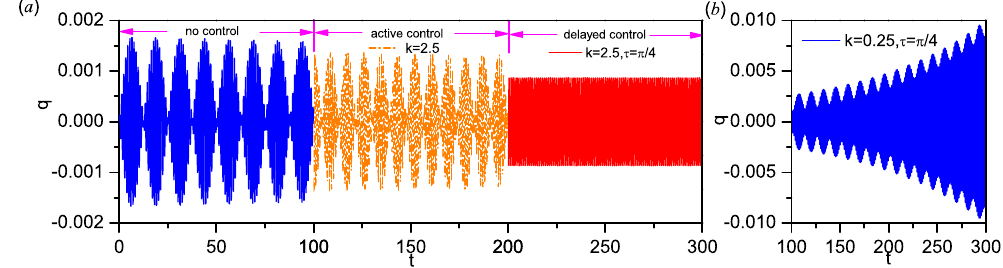
Figure 4. Time history curve of the system response. ( a ) Time history curve under no control, active control, and time delay feedback control; ( b ) increased response under time delay feedback